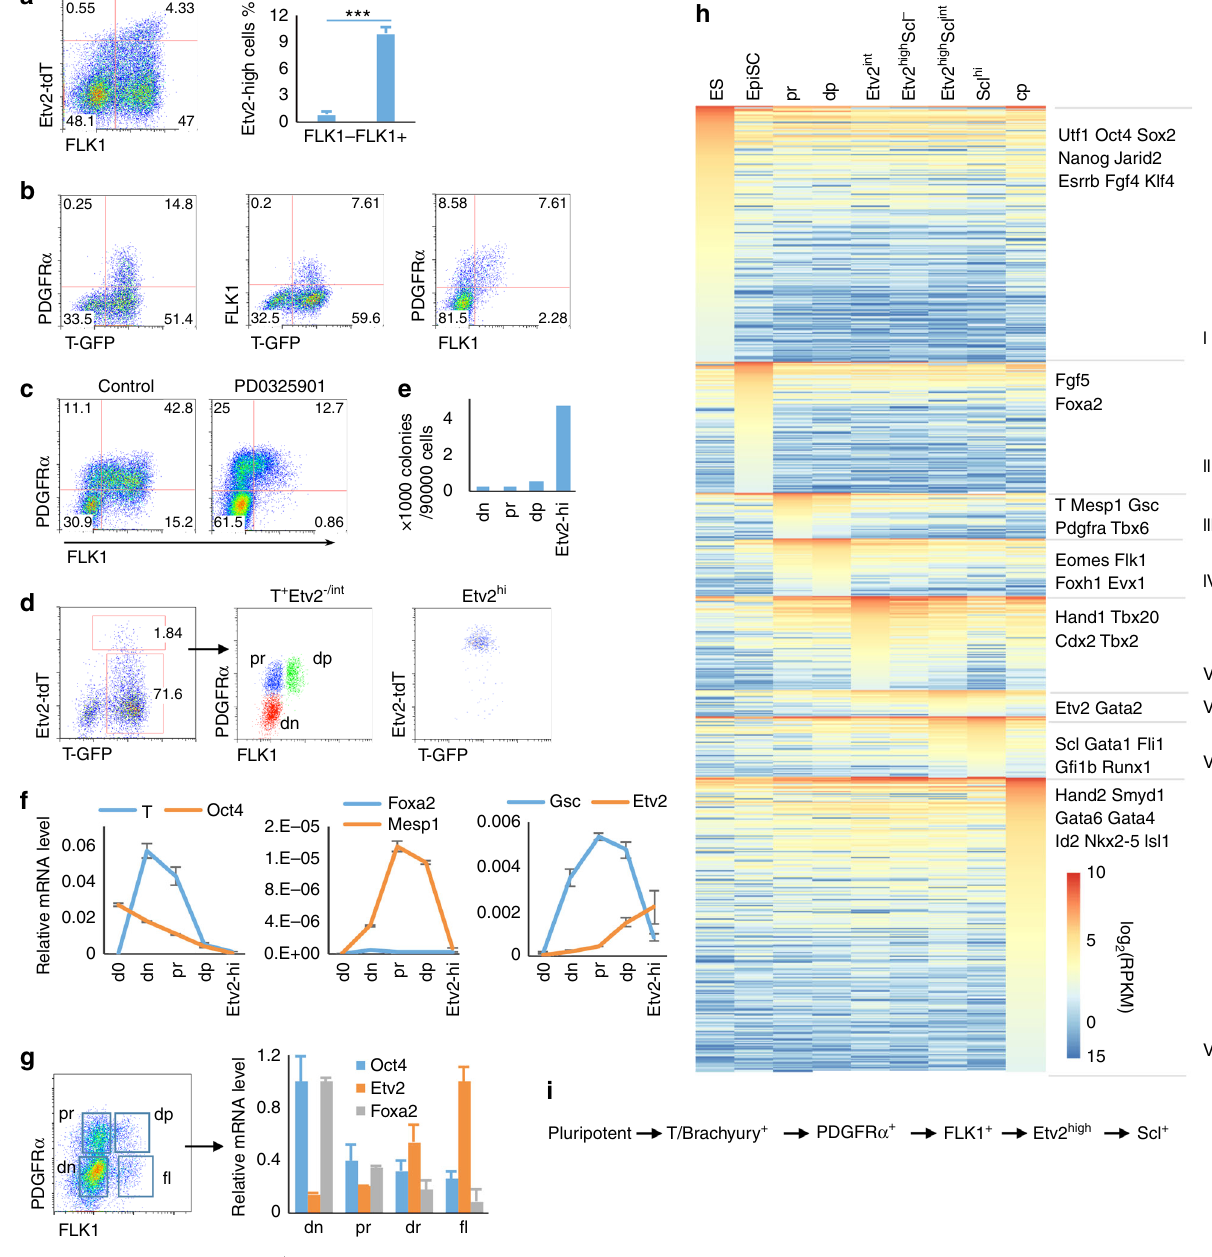
Fig. 2 Developmental route of Etv2 hi hemangiogenic progenitors. a FACS plot of Etv2-tdTomato and FLK1 in D4 SGET EBs is shown on the left . The percentage of Etv2 high cells within FLK1-negative or -positive cells is shown on the right . *** P value < 0.001 in Student ’ s t test, n = 3. Error bars are s.d. b Coexpression patterns of PDGFR α vs. T-GFP, FLK1 vs. T-GFP, and PDGFR α vs. FLK1, in D2.5 TGET EBs. c D3.5 SGET EBs treated with DMSO (control) or ERK inhibitor PD0325901 (2 μ M) were analyzed for PDGFR α and FLK1 expression by fl ow cytometry. PD0325901 was added from D2.5 to 3.5. d FACS sorting scheme of various mesodermal cell populations from D3.5 TGET EB is shown. T-GFP + PDGFR α - FLK1 − ( dn ), T-GFP + PDGFR α + FLK1 − ( pr ), and PDGFR α + FLK1 + ( dp ). e Blast colony number obtained from various cell populations as sorted in d is shown. f Marker gene expression pattern in the sorted populations as in d is shown. D0 indicates undifferentiated ES cells. g Indicated populations were sorted from E7.5 embryos and analyzed for relative mRNA levels. h Comparative transcriptome analysis for indicated cell populations is shown. Three thousand eight hundred fi fteen genes that are expressed in at least one sample and have a minimal RPKM change of 5-fold among the samples were chosen for comparison. ES undifferentiated mouse embryonic stem cells, EpiSC ES cell-derived epiblast stem cells, “ pr ” and “ dp ” were already described in d ; Etv2 int , Etv2 hi Scl − , Etv2 hi Scl int , and Scl hi cells were described in Fig. 1e; “ cp ” , ES cell-derived cardiac progenitors 25 . The D6 endoderm sample is not shown in the plot, but is included in the differential expression analysis and Supplementary Data 2. i Schematic diagram shows a developmental route of ES cells to the Etv2-tdTomato hi(gh) /Scl-GFP + hemangiogenic